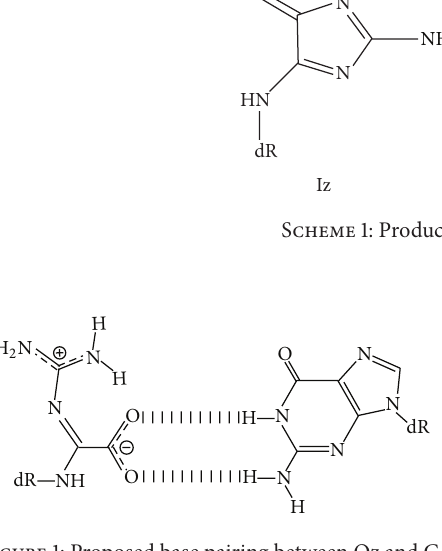
Figure 1: Proposed base pairing between Oz and